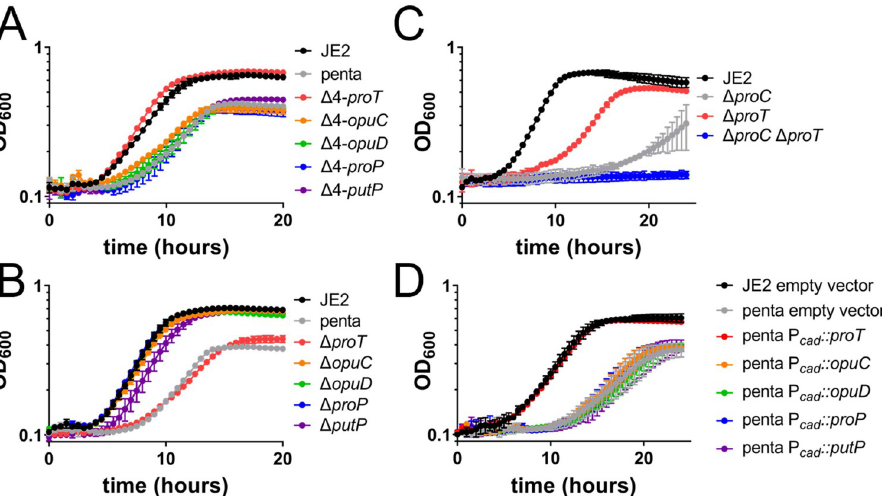
(Fig 4). In comparison to JE2, the penta mutant had reduced growth rate and yield in CDM containing 1 M NaCl suggesting that proline transport is beneficial under these growth condi- tions. (Fig 4A). Moreover, JE2 Δ 4- proT phenocopied wildtype growth, indicating that ProT is the primary proline transporter that supports growth in high salt (Fig 4A). Surprisingly, growth is still reduced in the Δ 4- putP strain (Fig 4A), suggesting that PutP- mediated proline